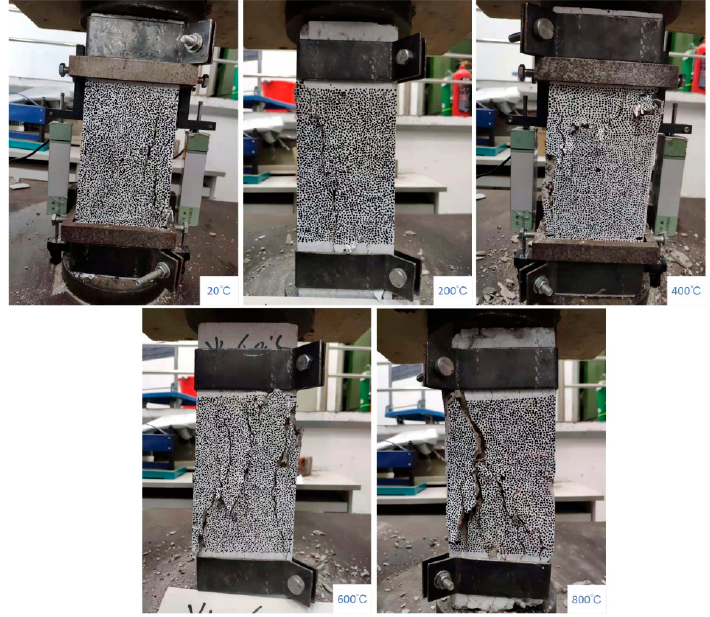
Figure 5. Destruction mode of SAC at different temperatures.